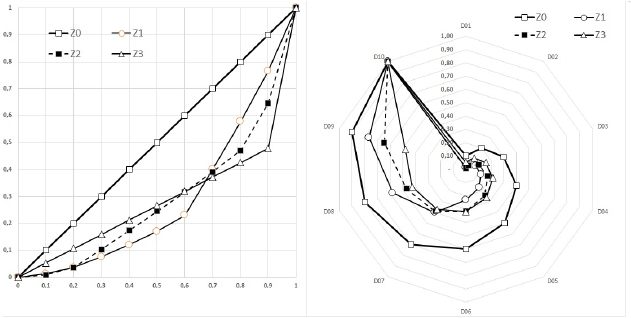
Figure 2. Left side: an exemplary data structure, the concentration of which is described by the Lorenz curves. Right side: there are clear differences between these curves for GINI and G R indicators. Source: own study.